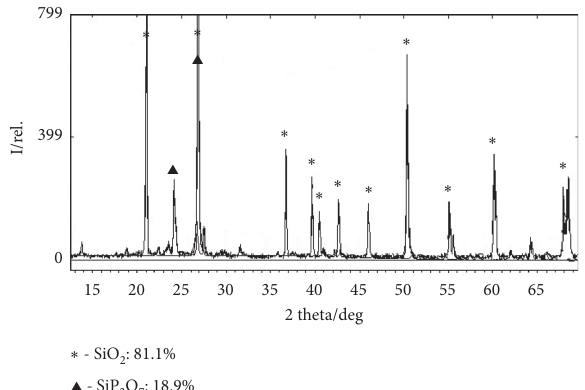
Figure 1: X-ray analysis of the composition of dust silicon (5 mass units) and orthophosphoric acid (3 mass units), strengthened at 300 ° S